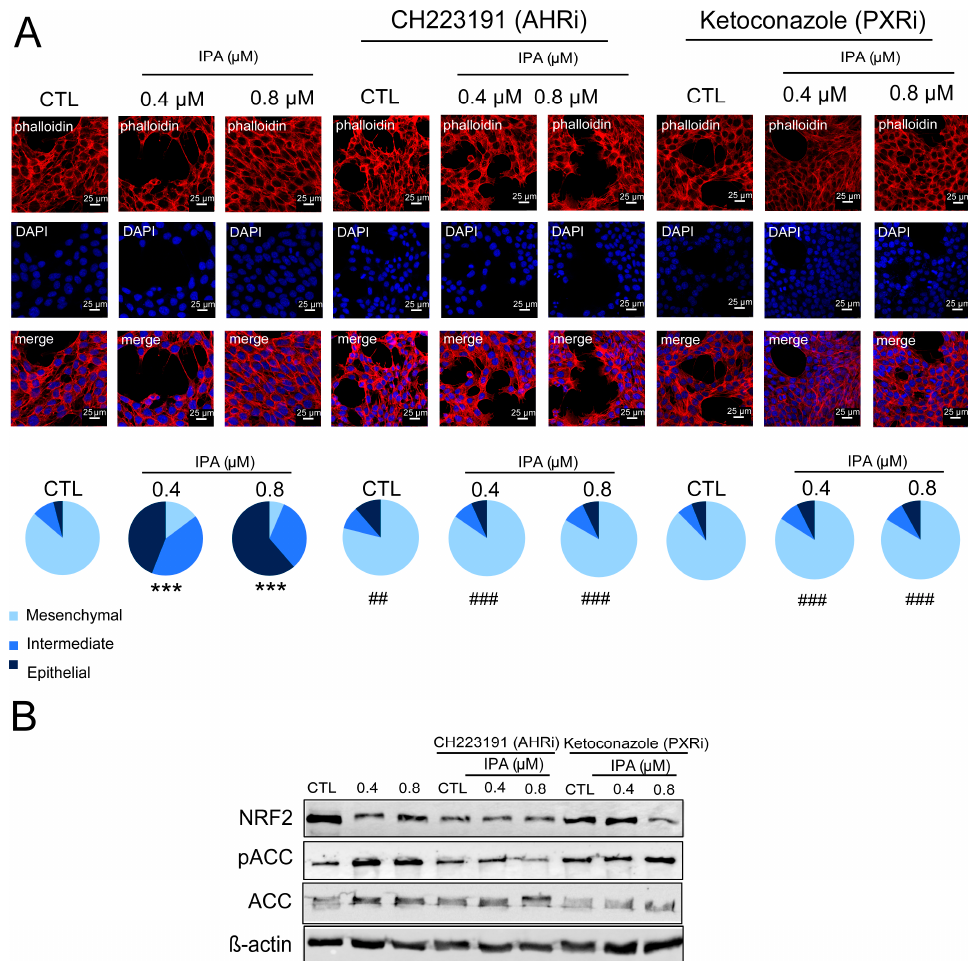
Figure 6. AHR and PXR are responsible for the IPA-elicited antineoplastic effects. 100,000 cells/well 4T1 cells were treated with IPA in the concentrations indicated for 24 h with or without the inhibitors, as indicated. Subsequently, ( A ) the actin cytoskeleton was stained using phallodin-Texas Red, and morphology was assessed using confocal microscopy. ( B ) On the same cells, the expression of the indicated proteins were determined by Western blotting. Fold data were log2 transformed to achieve normal distribution. Statistical significance was determined using an ANOVA test followed by Dunnett’s post-hoc test, except for panel A, where a chi-square test was conducted. *** indicate statistically significant difference between control and IPA treated samples at p < 0.01. ## and ### indicate significant difference between control and CH223191 or ketoconazole-treated samples at p < 0.01 or p < 0.001, respectively. Abbreviations: PXRi—PXR inhibitor, AHRi—AHR inhibitor, ACC— acyl-CoA carboxylase (an AMPK target protein).